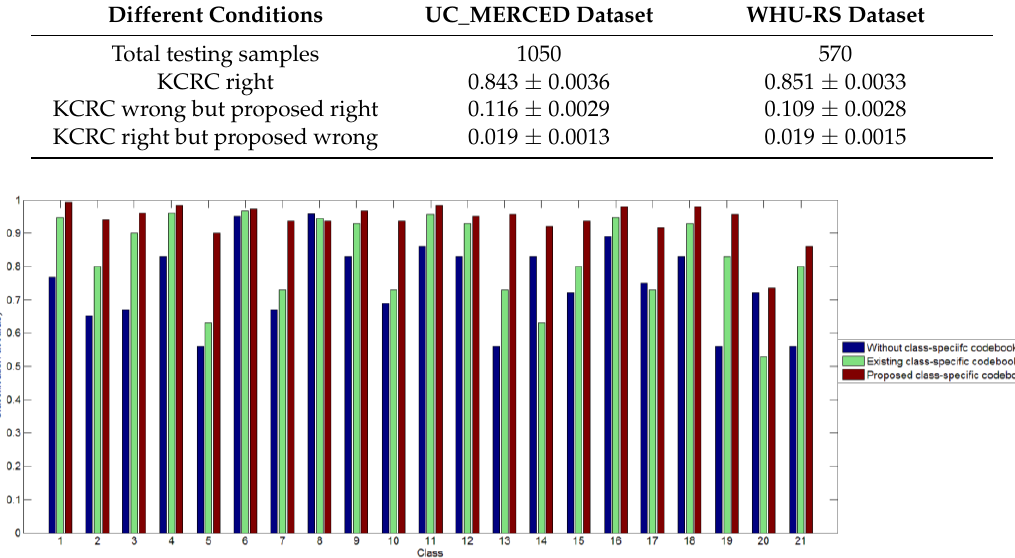
Figure 11. Classification accuracy per class for classifiers using UC_MERCE dataset. The class labels are assigned as follows: 1 = Agricultural, 2 =airplane, 3 = baseball diamond, 4 = beach, 5 = buildings, 6 = chaparral, 7 =dense residential, 8 = forest, 9 = freeway, 10 = golf course, 11 = harbor, 12 = intersection, 13 = medium residential, 14 = mobile home park, 15 =overpass, 16 = parking lot, 17 = river, 18 = runway, 19 = sparseresidential,20 = storage tanks, and 21 = tennis court.